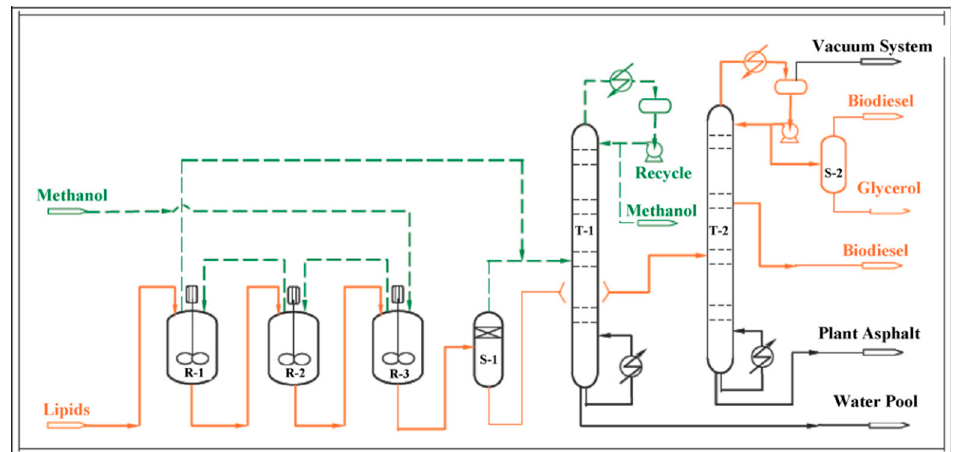
Figure 16. Process flow diagram of biodiesel production by solid acid catalysis (Copyright of Elsevier, see [24]).